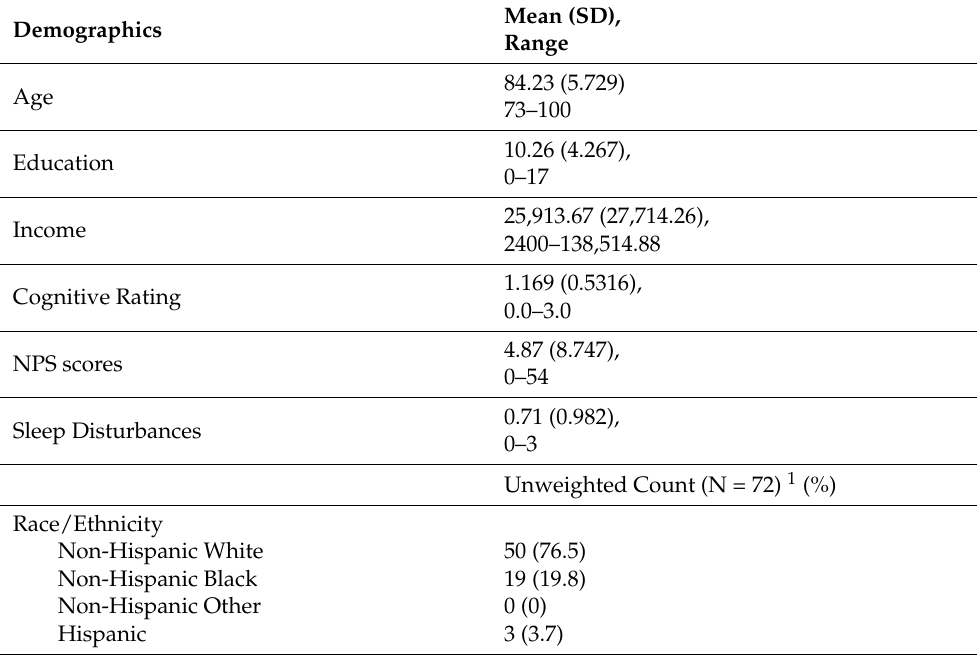
Table 1. Description of Sample ( N =